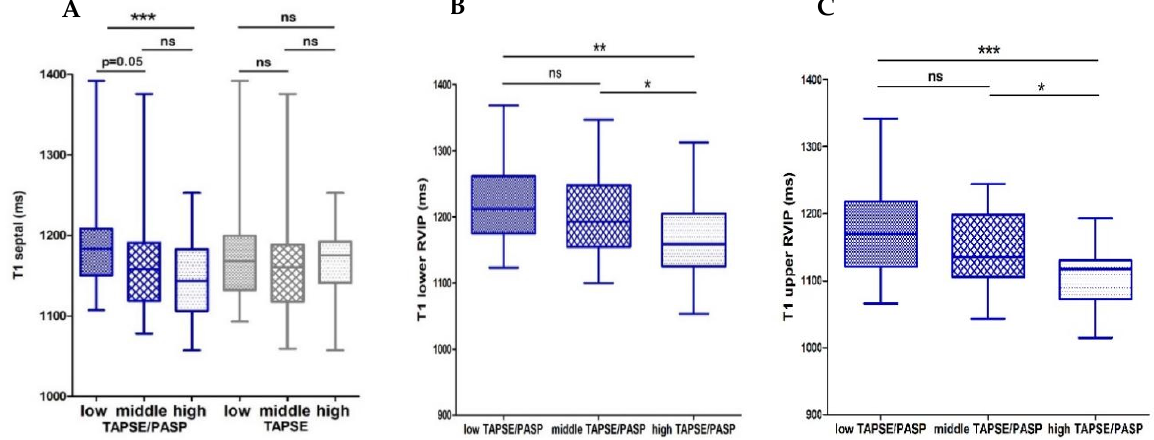
Figure 3. Box plots showing T1 relaxation time values of TAPSE/PASP and TAPSE tertiles. Those shown are values for ( A ) T1 septal divided according to TAPSE/PASP and TAPSE tertiles, ( B ) T1 lower right ventricular insertion point (RVIP) and ( C ) upper RVIP divided according to TAPSE/PASP tertiles. Boxes represent median with IQR. ns, not significant, * p < 0.05, ** p < 0.01, *** p < 0.001.